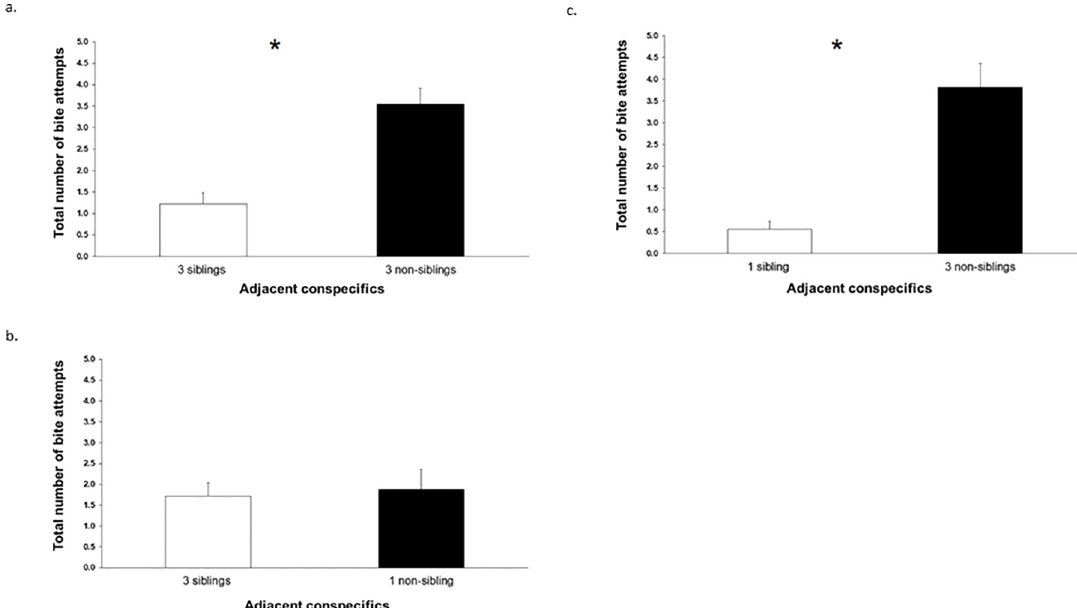
Fig 3. The total number of bite attempts (mean ± s.e.) directed by a focal larva toward adjacent conspecifics during 30 min sessions, in the experimental aquarium, within 2 cm away from these conspecifics, when there were in: (a) Experiment A: three siblings in one side chamber versus three non-siblings in the other side chamber, (b) Experiment B: three siblings in one side chamber versus one non- sibling in the other side chamber, (c) Experiment C: one sibling in one side chamber versus three non-siblings in the other side chamber. In each of the three experiments, total is shown for each of the two groups of conspecifics averaged across the two side chambers (right or left). An asterisk ( � ) denotes a significant difference (P < 0.05; sign test ) between the number of bite attempts directed toward the two groups of